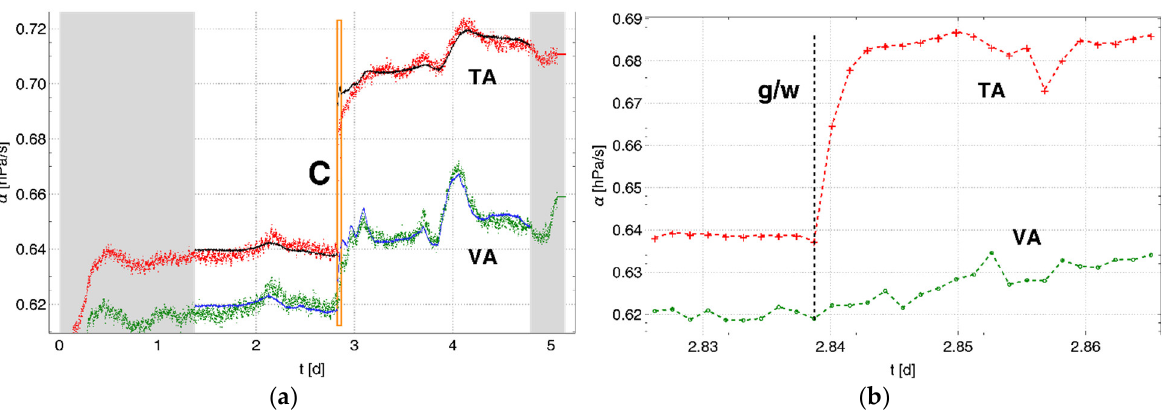
Figure 3. ( a ) Pressure changes analyzed in the test container (TA, red) and the vapor container (VA, green) versus the air container. Gray regions represent data that were not included in the investigation. Solid lines (TA: black, VA: blue) represent the calculated pressure changes. The data within the orange box marked C and shown in detail in ( b ) demonstrate the step-like increase in the pressure change (red) when water was added to cover the surface of the membrane tube in the test container (black dashed line, marked g/w). However, the pressure change (green) in the vapor container changed gradually.